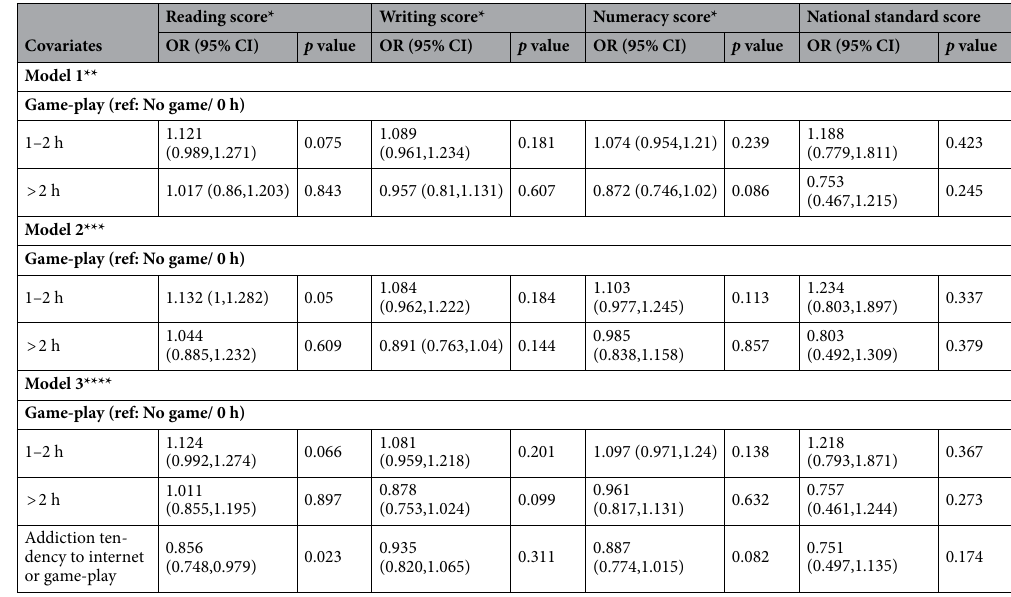
Table 5. Generalized linear model fitted to various scores and national standard scores for weekdays game- play adjusting the behavioural and sociodemographic factors, as well as survey weights. *Standardized (mean of 0 and a standard deviation of 1). **The model was adjusted for age and sex of the child, household income, primary carer’s education and family type. ***Model 2 was adjusted for age and sex of the child,